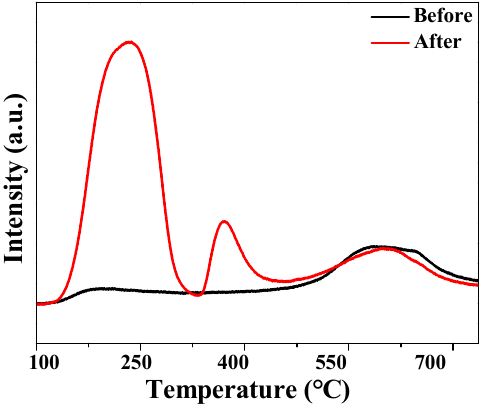
Figure 3. NH 3 ‒TPD tests of NMGM before and after hydrothermal 1 d. Figure 3. NH 3 -TPD tests of NMGM before and after hydrothermal 1